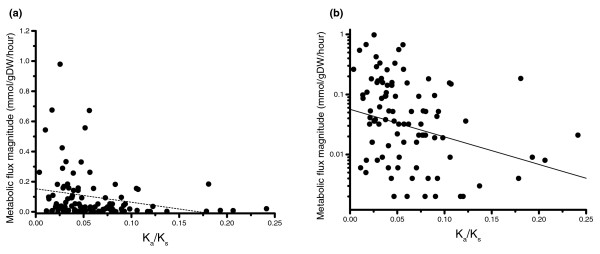
The relationship between metabolic flux and evolutionary constraint.(a) The relationship between metabolic flux values and evolutionary constraint Ka/Ks for aerobic growth on glucose. (maximal uptake rate for glucose 15.3 mmol/g dry weight (DW)/h; maximal oxygen uptake 0.2 mmol/gDW/h). Spearman's rank correlation r = -0.30; P = 2.7 × 10-3; Pearson's correlation r = -0.24, P = 1.7 × 10-2. The metabolic fluxes were calculated using flux balance analysis to maximize the cell growth rate. Fluxes more than two orders of magnitude larger than the median non-zero flux - representing large glycolytic fluxes - were excluded from the analysis. (b) The same as (a) but using log coordinates for the metabolic flux magnitude.